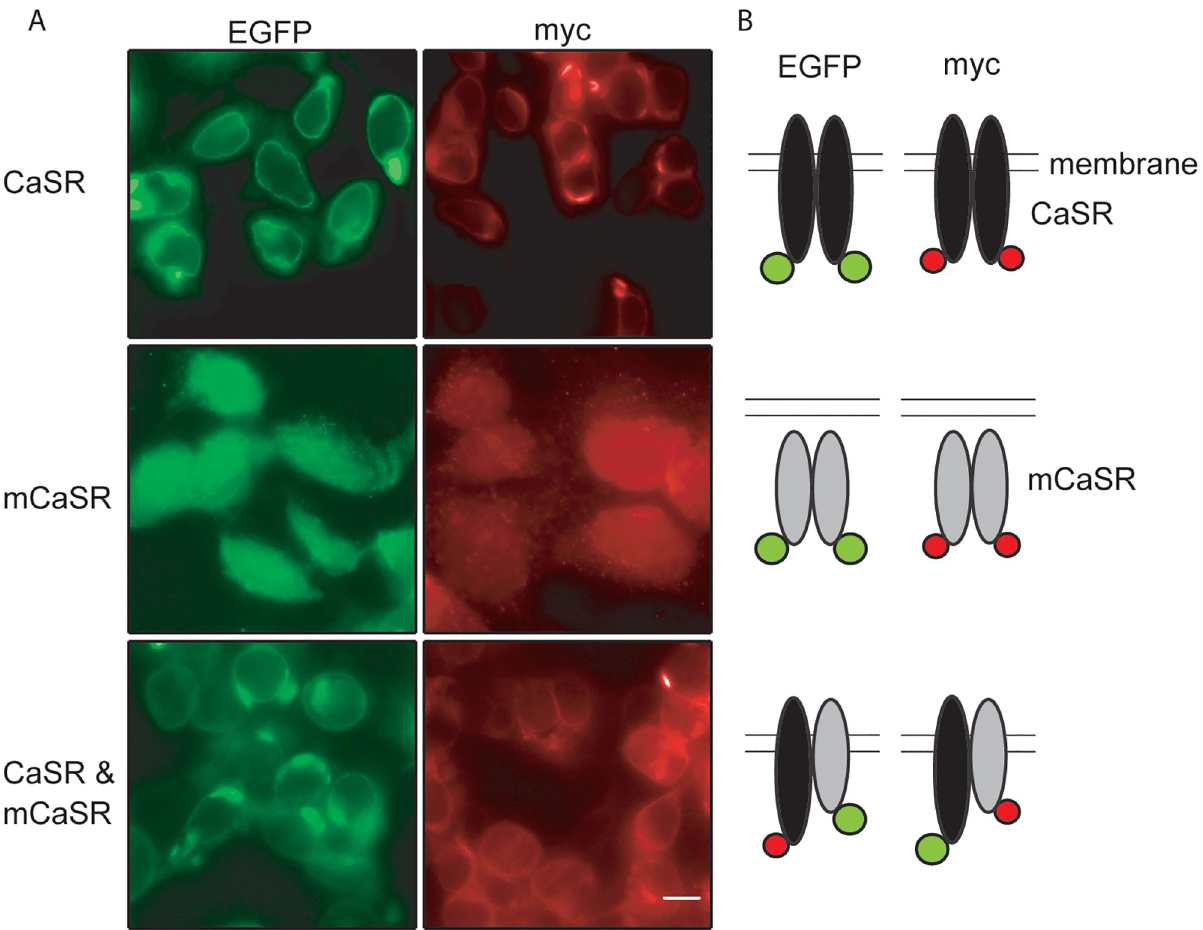
Fig 2. CaSR-mCaSR heterodimers reach the cell membrane. A, fluorescence images of HEK 293 cells transfected with CaSR and/or mCaSR fused with EGFP (left column) or myc epitope (right column). Cells were fixed and the myc tag detected using mouse anti-myc (1:500, Invitrogen) antibody and secondary goat anti-mouse antibody IgG AlexaFluor 594 (1:500). Scale bars = 10 μ m. The fluorescence was confined to the cell perimeters when CaSR was expressed regardless of the tag identity (upper row) but the fluorescence was central if mCaSR was expressed alone (middle row). Peripheral concentration of the fluorescently tagged mCaSR was observed following co-expression of CaSR and mCaSR (lower row). B, Model illustrating wild- type (black) or mutant (gray) CaSR distributions relative to the plasma membrane are similar regardless of whether tagged with EGFP or myc. Co- expression with CaSR results in some mCaSR accumulating at the cell